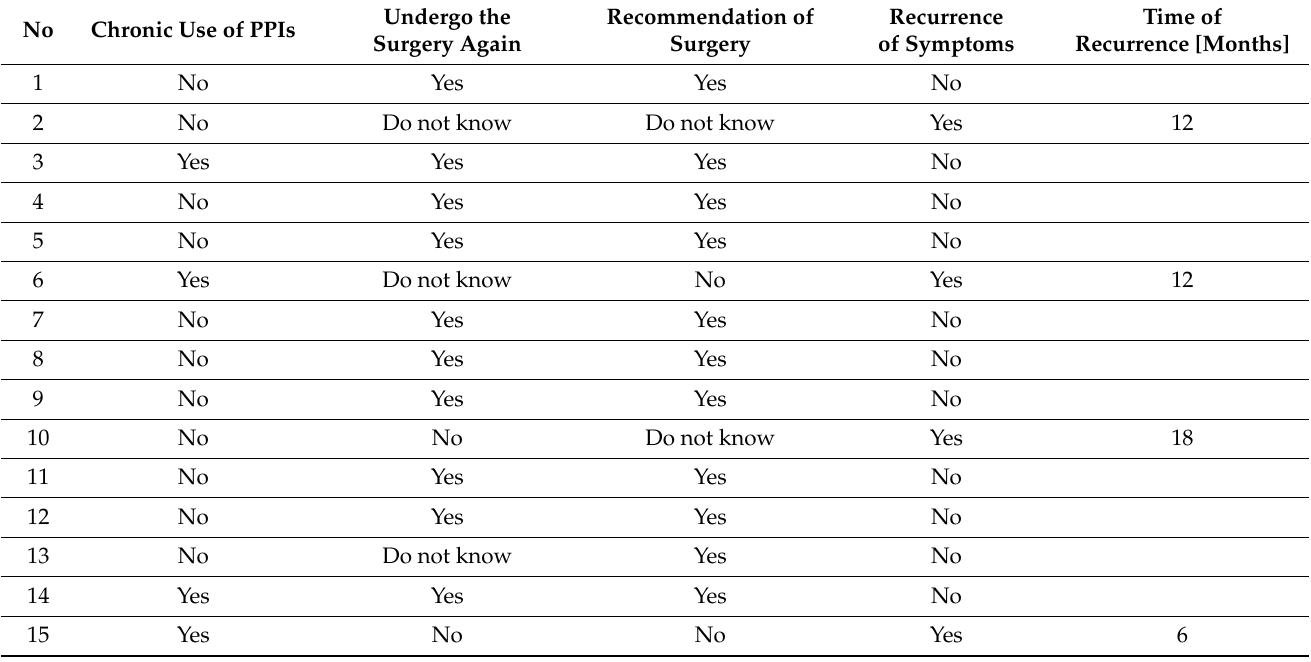
Table 1. Characteristics of patients after the